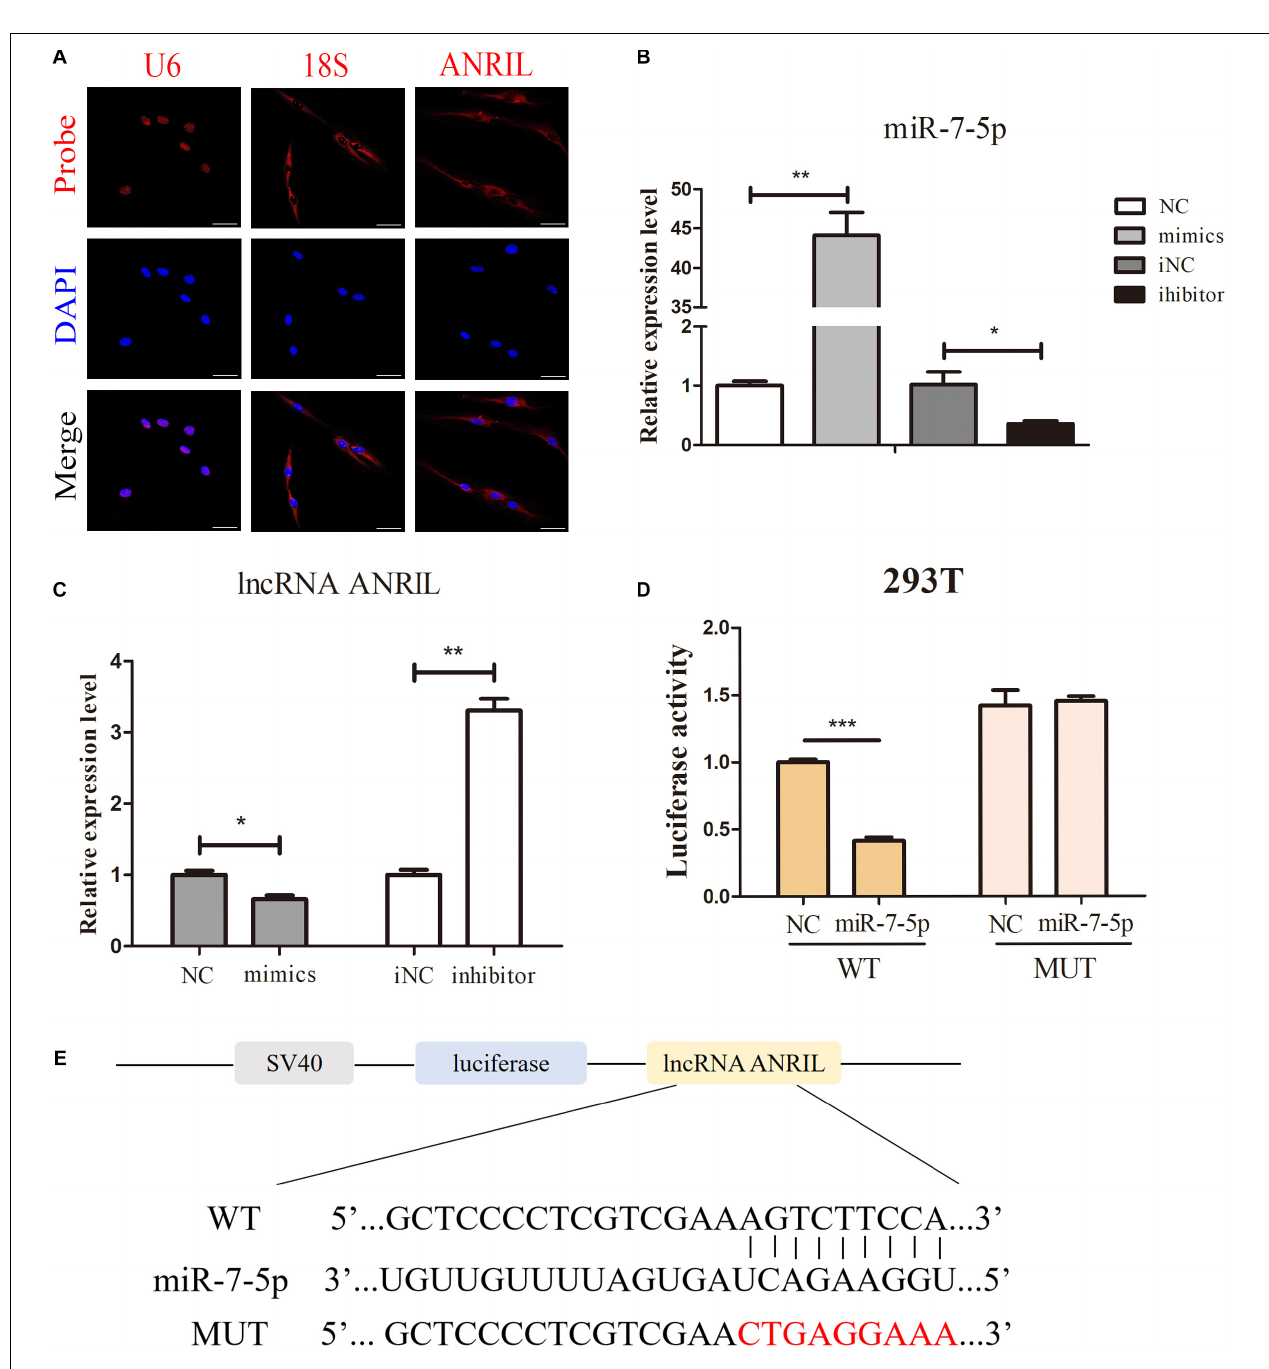
FIGURE 4 | LncRNA ANRIL acts as a sponge of miR-7-5p. (A) FISH assay showed the localization of lncRNA ANRIL in the cytoplasm. 18S and U6 were the internal control. (B) Transfection efficacy of miR-7-5p mimics and inhibitor was determined by qPCR. (C) Relative lncRNA ANRIL expression level was measured by qPCR in iPDLSCs after transfected with miR-7-5p mimics or miR-7-5p inhibitor. (C) FISH assay showed the localization of lncRNA ANRIL in the cytoplasm. 18S and U6 were the internal control. (D,E) The binding of miR-7-5p to ANRIL was validated by conducting the luciferase reporter assay. IPDLSCs were co-transfected with mimics-NC or miR-7-5p mimics and wild-type lncRNA ANRIL or mutant lncRNA ANRIL. Relative Renilla luciferase activity was normalized to that of firefly luciferase. Scale bar = 100 µ m (* P < 0.05, ** P < 0.01, *** P < 0.001).